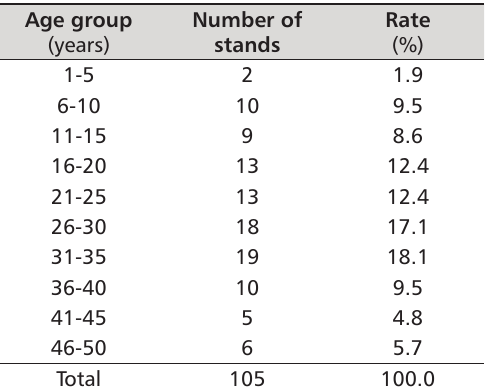
TABle 1. Distribution of the measured stands by age groups